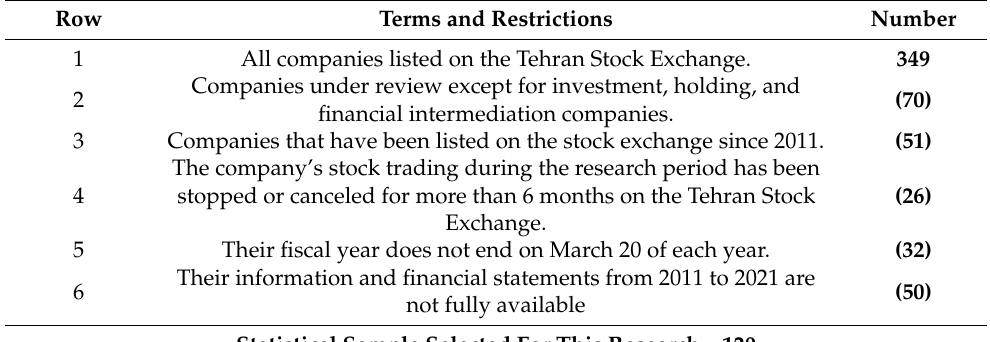
Table 1. Research sample selection